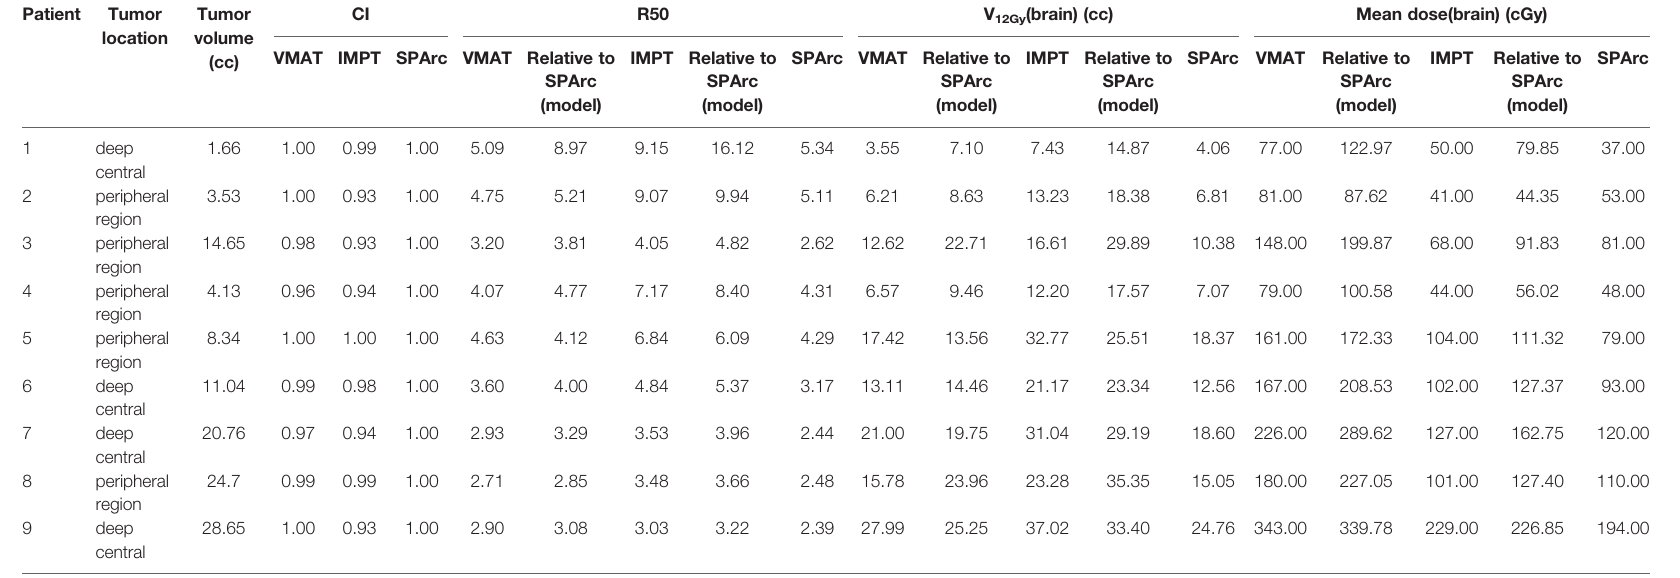
TABLE 2 | Validation of optimal brain sparing modality based on tumor size and location for 9 patients.